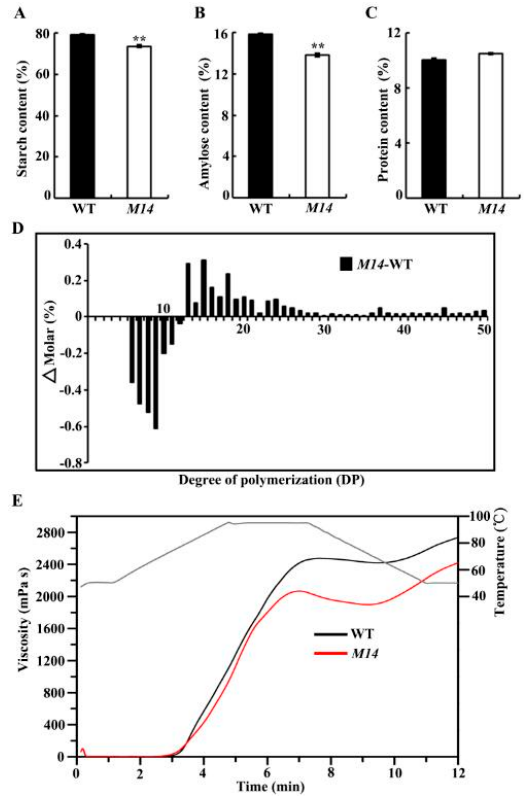
Figure 3. Components of seed and starch and pasting properties of starch. ( A – C ) Starch, amylose and protein contents in WT and M14 . All data are given as means ± SD ( n = 3). ** indicate significant differences between WT and M14 at p < 0.01 by Student’s t test. ( D ) Differences in chain length distributions of amylopectin between WT and M14 . ( E ) Pasting properties of starch from WT (black line) and M14 (red line) endosperm. The gray line indicates the temperature changes during the